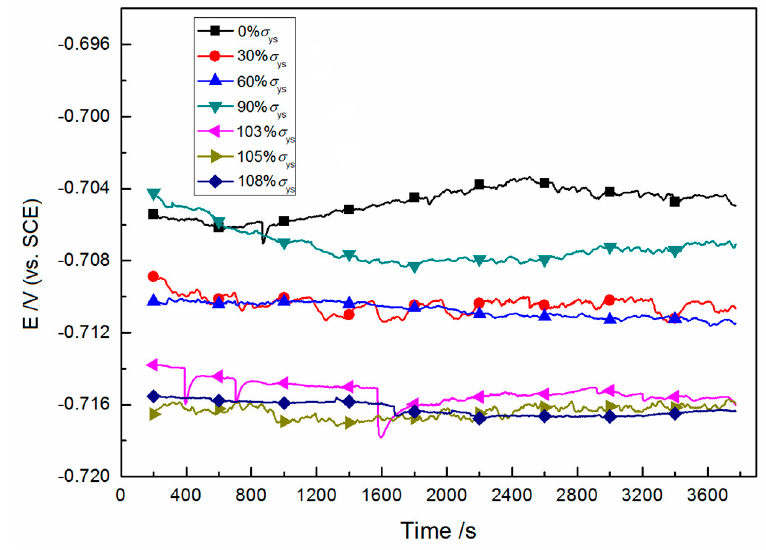
Figure 4. Open-circuit potential of X80 steel in 3.5 wt% NaCl aqueous solution with saturated CO 2 at 30 °C under different elastic and plastic tensile stress.